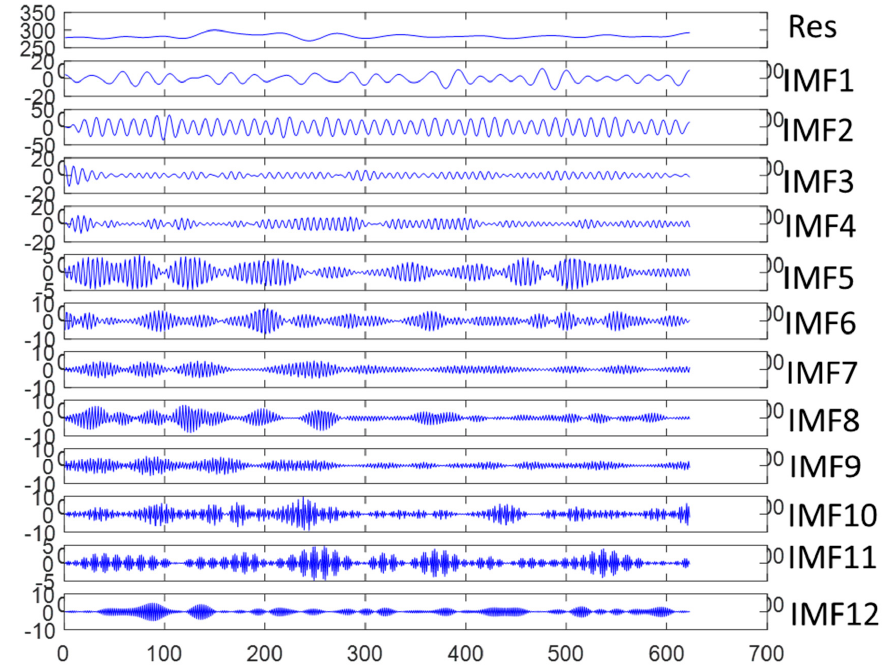
Figure 6. Modes extracted by empirical wavelet transform (EWT) for OCBA TCO ozone time series.